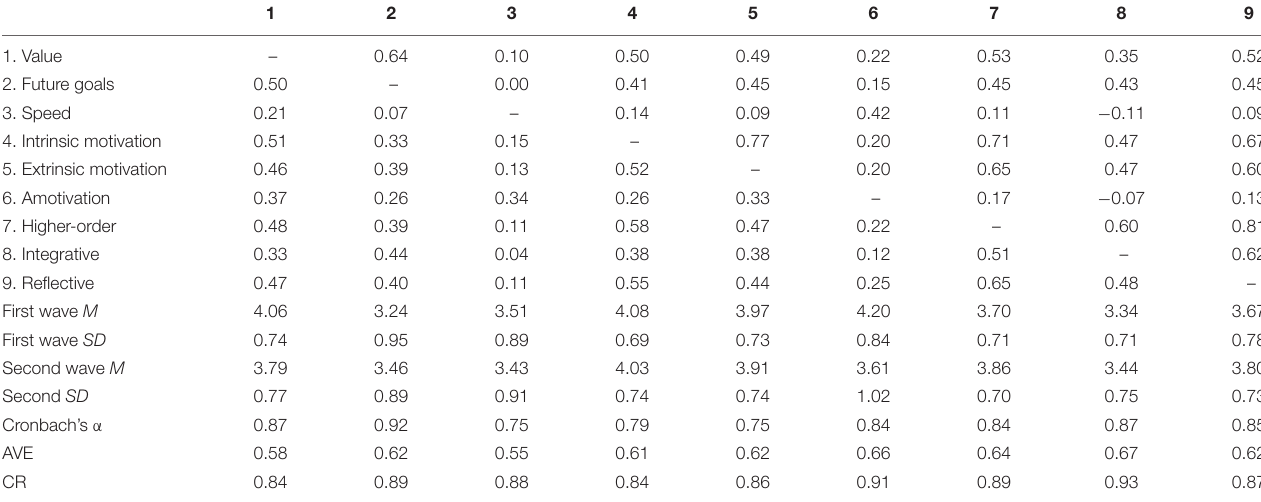
TABLE 2 | Measurement properties.